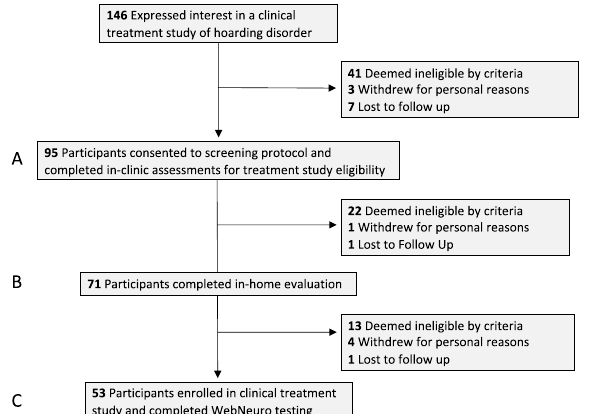
Figure 1. Participant flow diagram. Data were collected from individuals screening for and enrolling in study offering clinical treatment of hoarding disorder. ( A ) Participants underwent clinical assessments and self-rated their home clutter levels using the Clutter Image Rating (CIR). ( B ) 71 participants completed an in-home evaluation during which independent evaluators (IEs) rated home clutter levels using the CIR, thus allowing a measure of anosognosia based upon the relative discrepancy of self- vs IE-rated clutter. ( C ) 53 participants for whom a measure of anosognosia was obtained proceeded to the clinical treatment study and completed computer-based neurocognitive testing